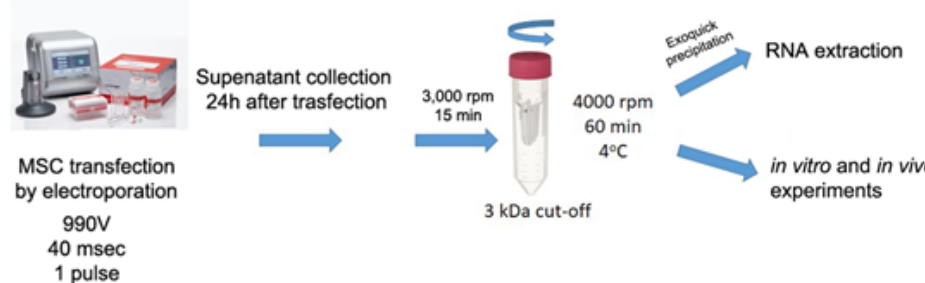
Figure 3. Schematic illustration of the engineering method used to transiently transfect MSCs. MSCs were transfected via a neon electroporation system with different miRNA mimics. EVs were collected after 24 h and supernatant, previously centrifuged at 2000 g to eliminate cell debris, was concentrated by 3 kDa filter tube. EVs were then used for in vitro and in vivo experiments or precipitated by Exoquick and used for RNA extraction.